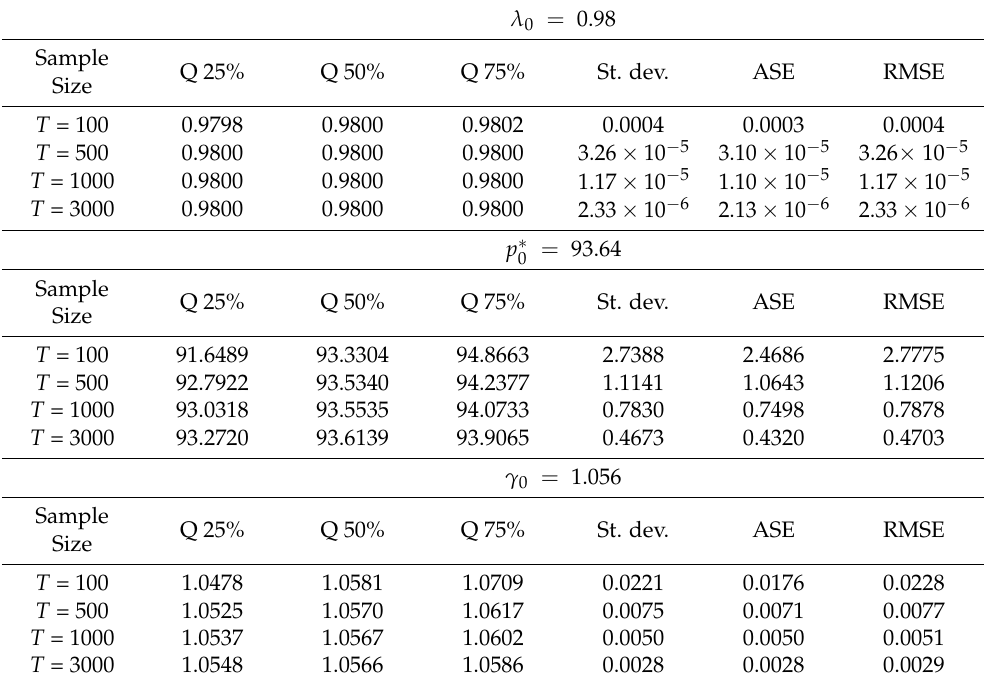
Table 2. Inverse consumption demand F(C) = 200 − C. True parameter values are λ 0 = 0.98, p ∗ γ 0 = 1.056.